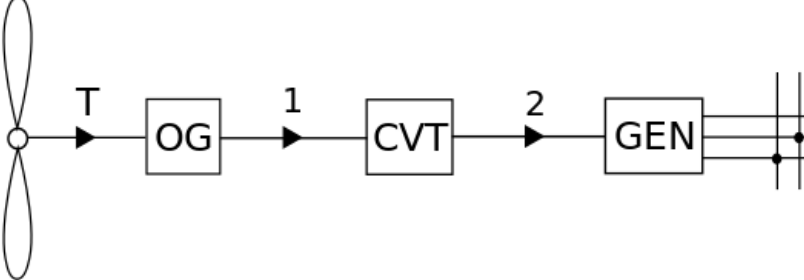
Figure 3. Schematic of the in-line HTS configuration. OG is the over-gear drive, CVT is the continuously variable transmission (the HTS in this case), and GEN is the electric